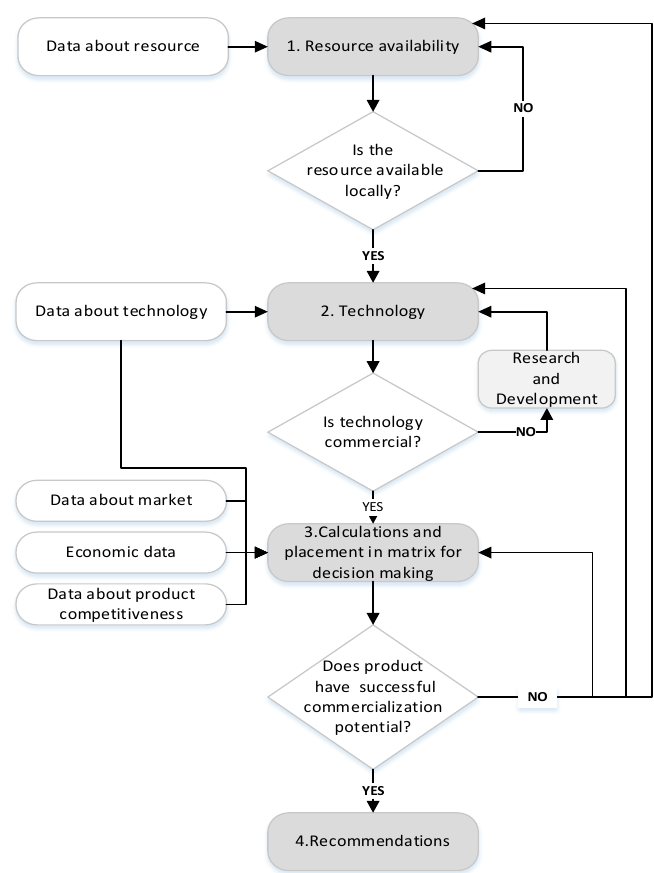
Fig. 1. Methodology